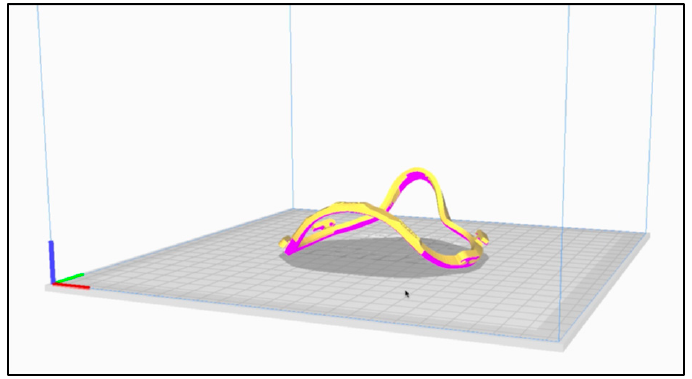
Figure 3. A GCode is generated by a 3D-printing slicing software (Ultimaker Cura).